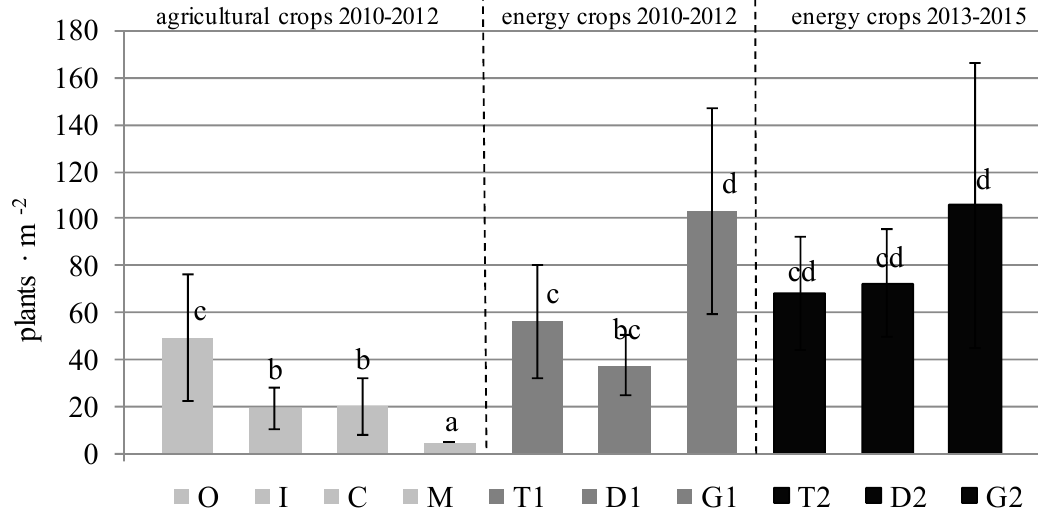
Figure 5. Weed flora density in crops cultivated in different farming systems and in groups of plants cultivated for energy purposes. Means and standard deviations are presented [ n = 12–60; n = 3 years × number of crops in rotation (from 1 to 5, Table 2) × 4 replications]. Values with the same letter are not significantly different according to the nonparametric Kruskal ‒ Wallis test ( p ≤ 0.05). Explanations